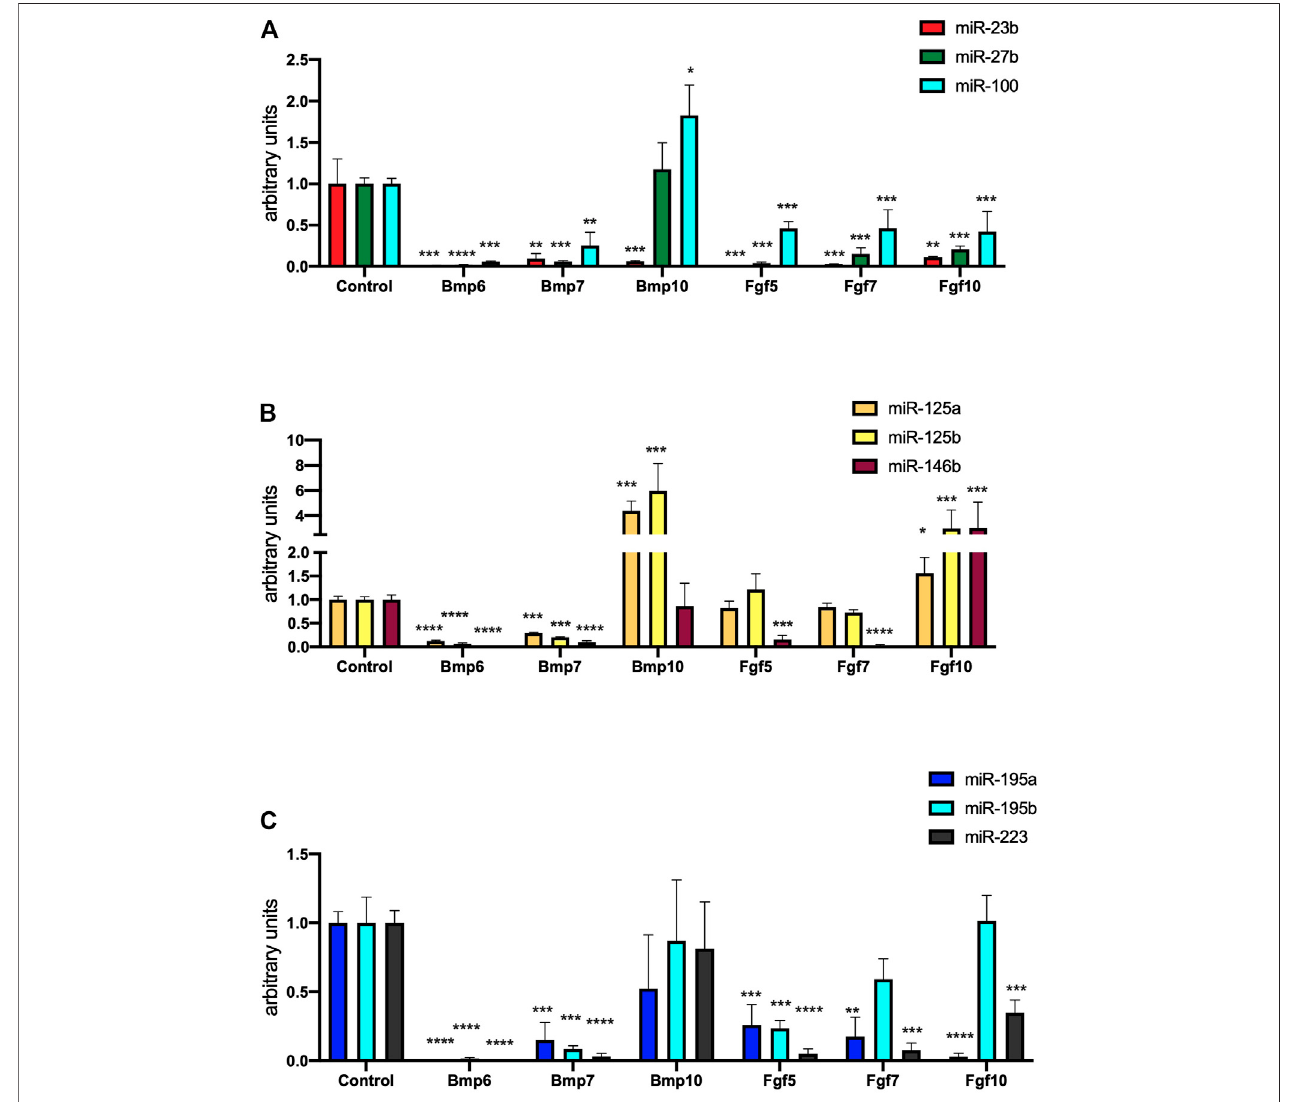
FIGURE 5 | Panel (A) RT-qPCR analyses of miR-23b, miR-27b and miR-100 expression after control, Bmp6, Bmp7, Bmp10, Fgf5, Fgf7 and Fgf10 treatments, respectively,tomouseE9.5PE/STexplants.Panel (B) RT-qPCRanalysesofmiR-125a,miR-125band miR-146bexpressionafter control,Bmp6,Bmp7, Bmp10,Fgf5, Fgf7 and Fgf10 treatments, respectively, to mouse E9.5 PE/ST explants. Panel (C) RT-qPCR analyses of miR-195a, miR-195b and miR-223 expression after control, Bmp6, Bmp7, Bmp10, Fgf5, Fgf7 and Fgf10 treatments, respectively, to mouse E9.5 PE/ST explants. * p < 0.05, ** p < 0.01, *** p < 0.001, **** p < 0.0001.